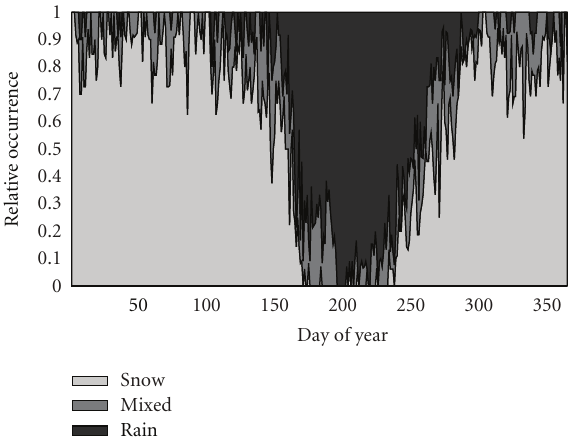
Figure 2: Relative occurrence of precipitation types in the period 13.9.1982 till 17.9.2007 at Ny- ˚Alesund.